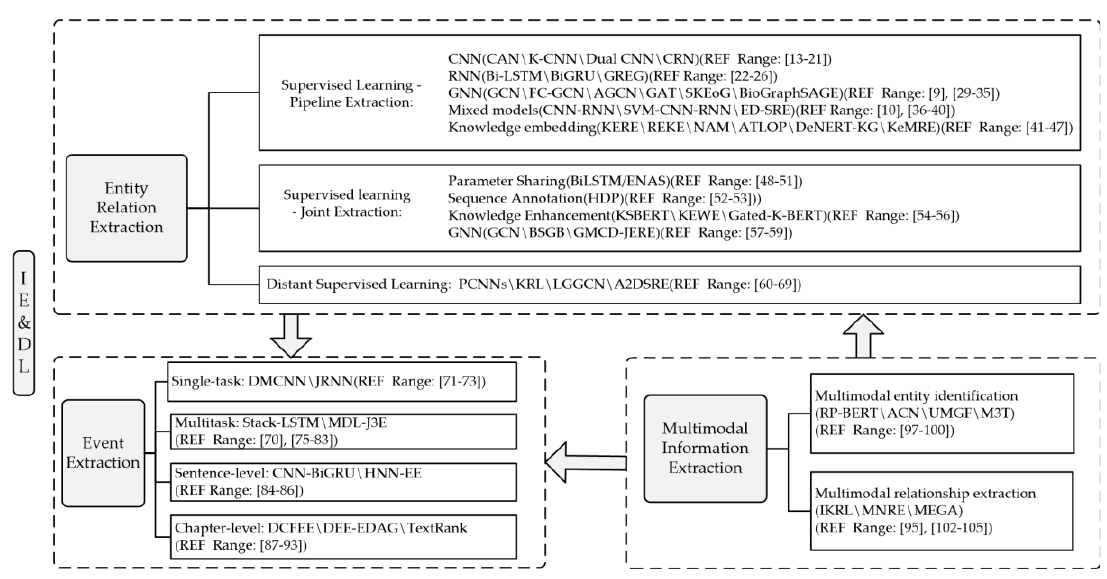
Figure 1. Overall architecture of IE based on DL.